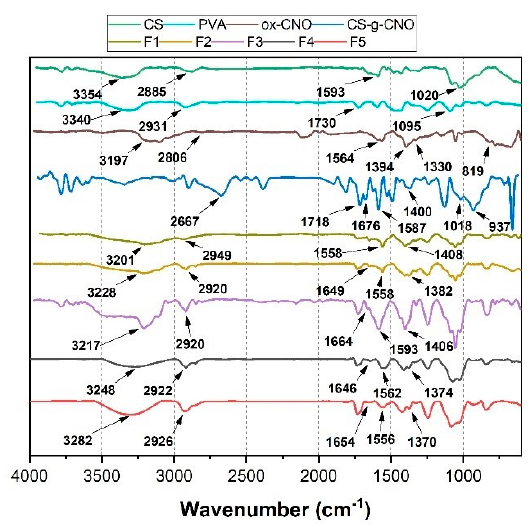
Figure 6. Attenuated total reflectance Fourier-transform infrared spectroscopy (ATR-FTIR) of the